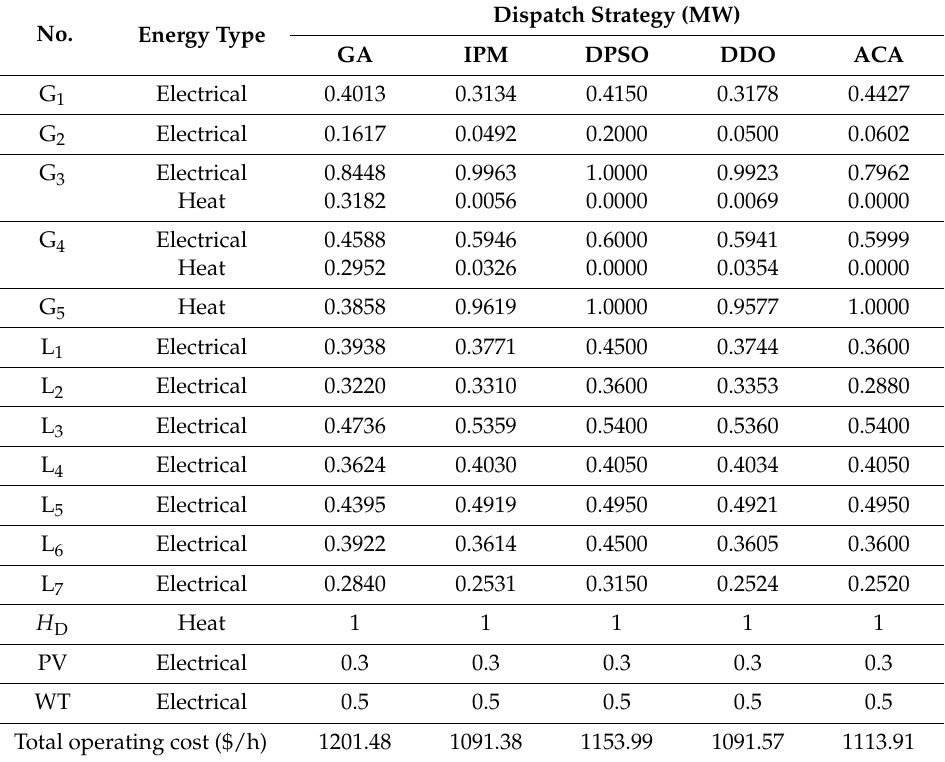
Table 3. Obtained dispatch strategies under scenario